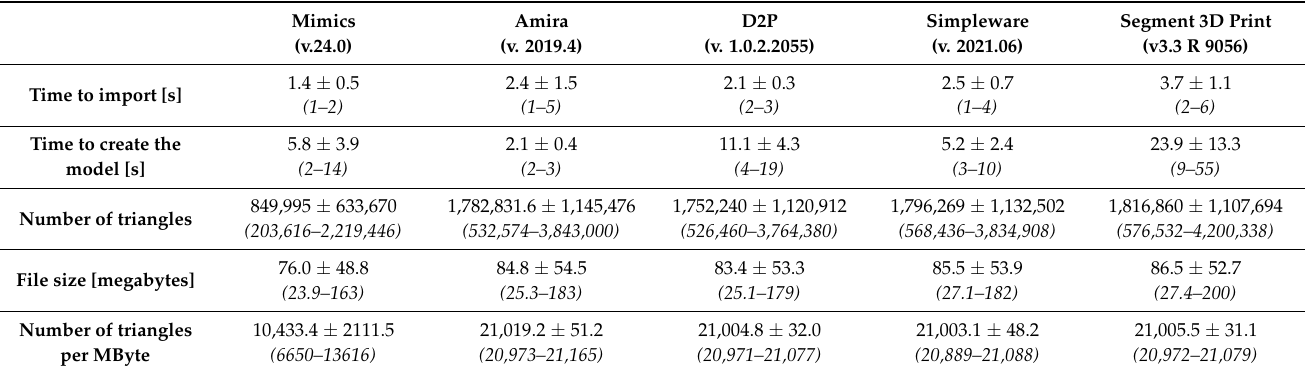
Table 2. Main features of the five software packages analyzed. The results are means ± standard deviation over the fifteen models analyzed (five anatomical areas, each from three subjects), along with range values (min–max). For the sake of comparison, the table format is similar to that reported in the previous work [25] (with the exception of information related to basic two-dimensional and 3D features, which is not reported